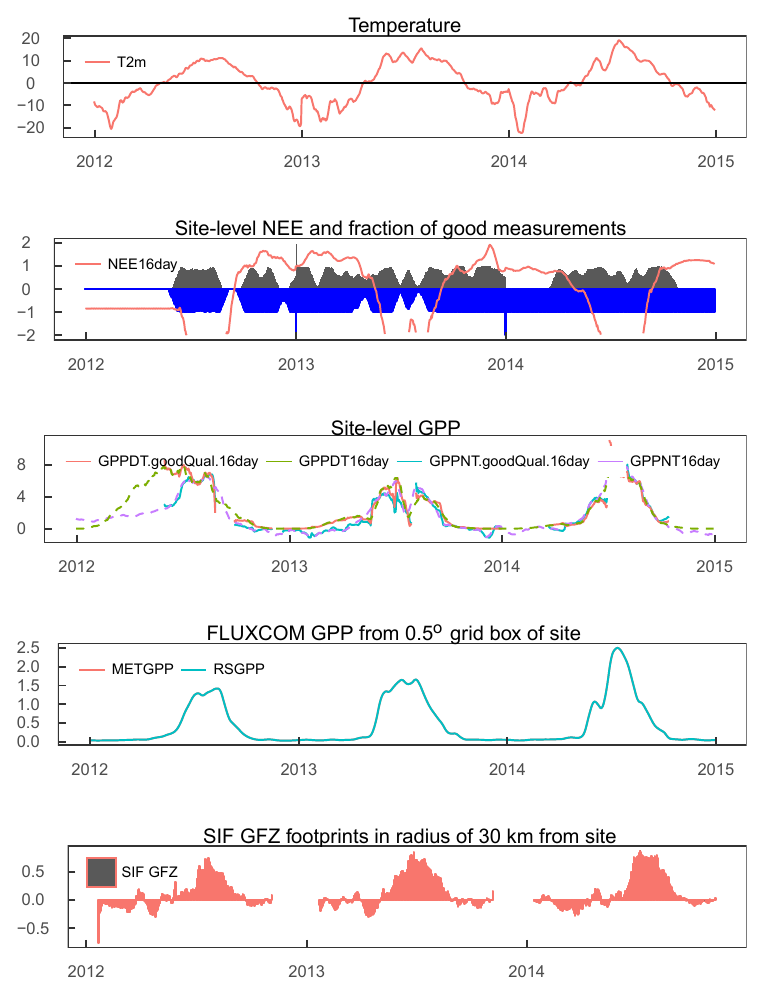
Figure A11. SE-St1: Time series (16 day averages) of quality filtered air temperature and NEE; blue bars indicate fraction of available good quality temperature data and gray bars indicate fraction of good and gap-filled NEE data. The middle panel depicts the GPP derived from the night-time and daytime partitioning of NEE measurements, filtered for 80% of good quality and gap-filled NEE along with unfiltered measurements. The modelled GPP is taken from the 0.5 ◦ grid cell with centre coordinates closest to the tower. The bottom panel displays the 16 day averages of SIF GFZ footprints within 30km of the